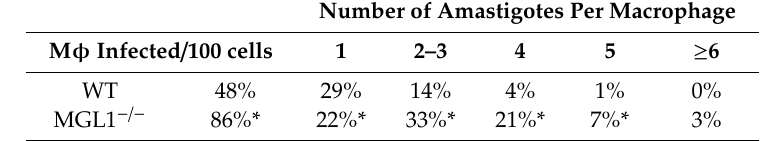
Figure 1. Expression of MGL1 and MGL2 in M φ in response to T. cruzi antigen. PE-M φ (F4 / 80 + ) from WT or MGL1 − / − mice were stimulated for 24 or 48 h with Tc Ag (25 µ g / mL). Representative histogram and bar chart of the percentage of PE-M φ expressing MGL1 and MGL2 are shown in ( a ) and ( b ), respectively. Dotted line, isotype; gray area, PE-M φ from WT mice; solid line, PE-M φ from MGL1 − / − mice; n = 6 mice per group; * p < 0.05 and ** p < 0.002. Table 1. The numbers of M φ that exhibit at least one amastigote, and the number of intracellular amastigotes per M φ